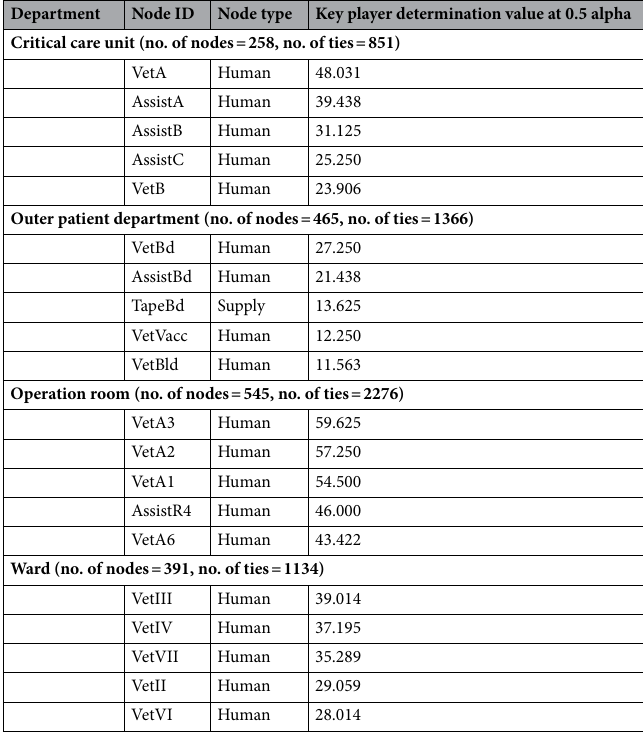
Table 1. Nodes with the highest key player determination values per